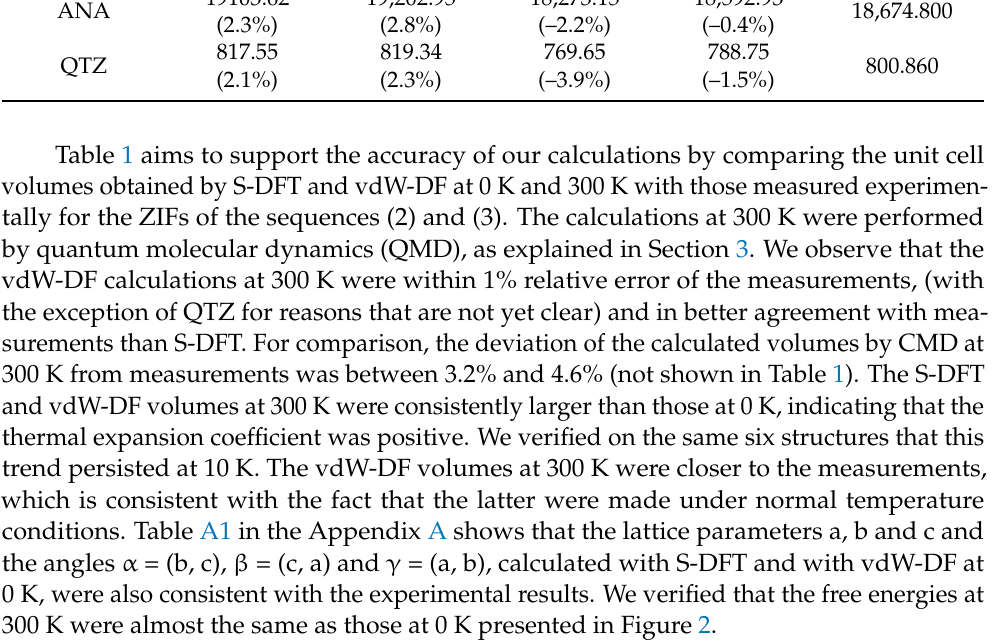
Table 1 aims to support the accuracy of our calculations by comparing the unit cell volumes obtained by S-DFT and vdW-DF at 0 K and 300 K with those measured experimen- tally for the ZIFs of the sequences (2) and (3). The calculations at 300 K were